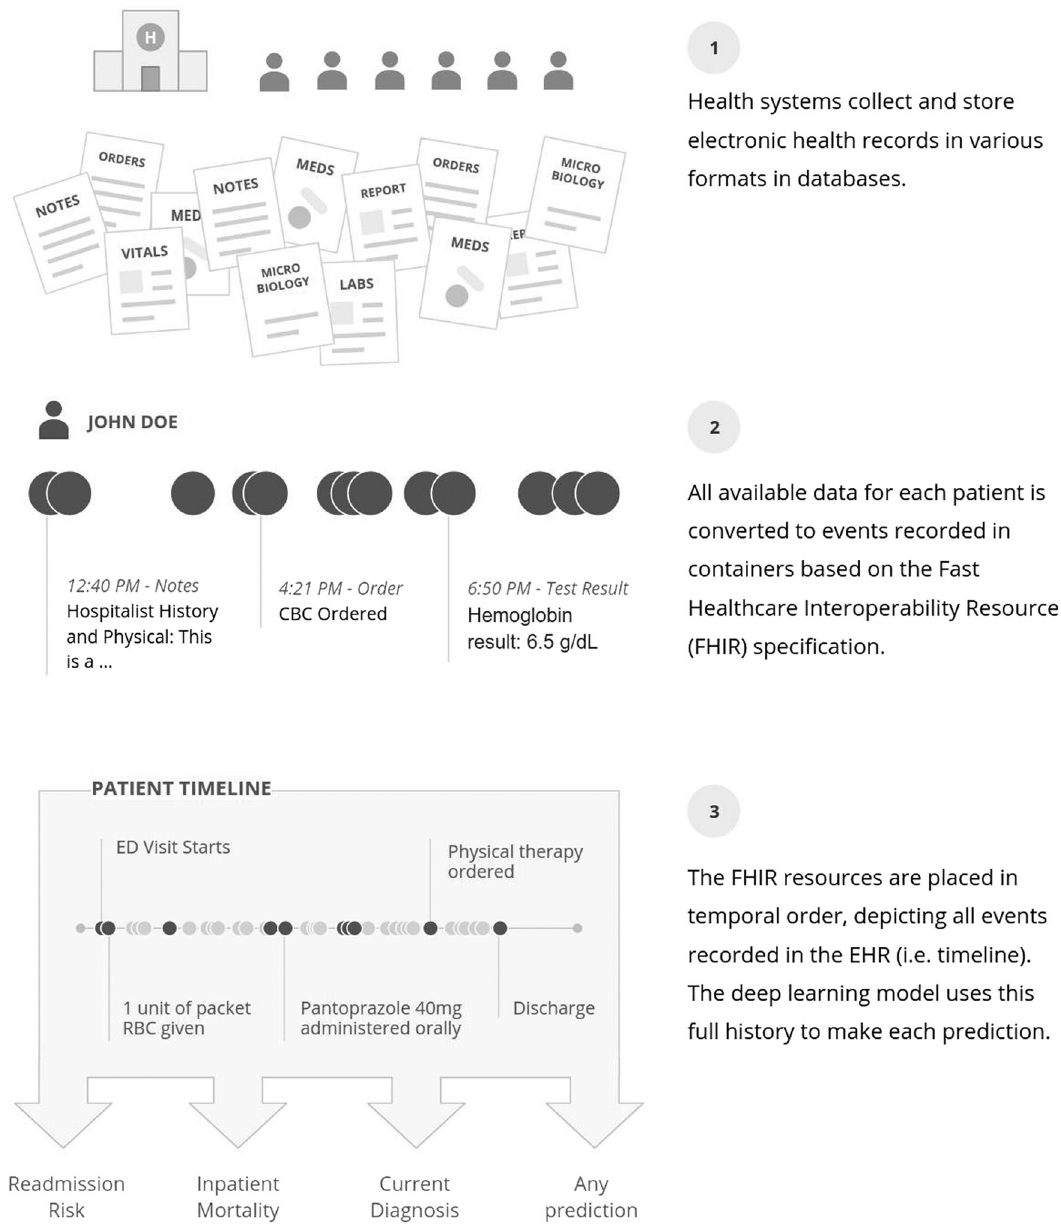
Fig. 4 Data from each health system were mapped to an appropriate FHIR (Fast Healthcare Interoperability Resources) resource and placed in temporal order. This conversion did not harmonize or standardize the data from each health system other than map them to the appropriate resource. The deep learning model could use all data available prior to the point when the prediction was made. Therefore, each prediction, regardless of the task, used the same